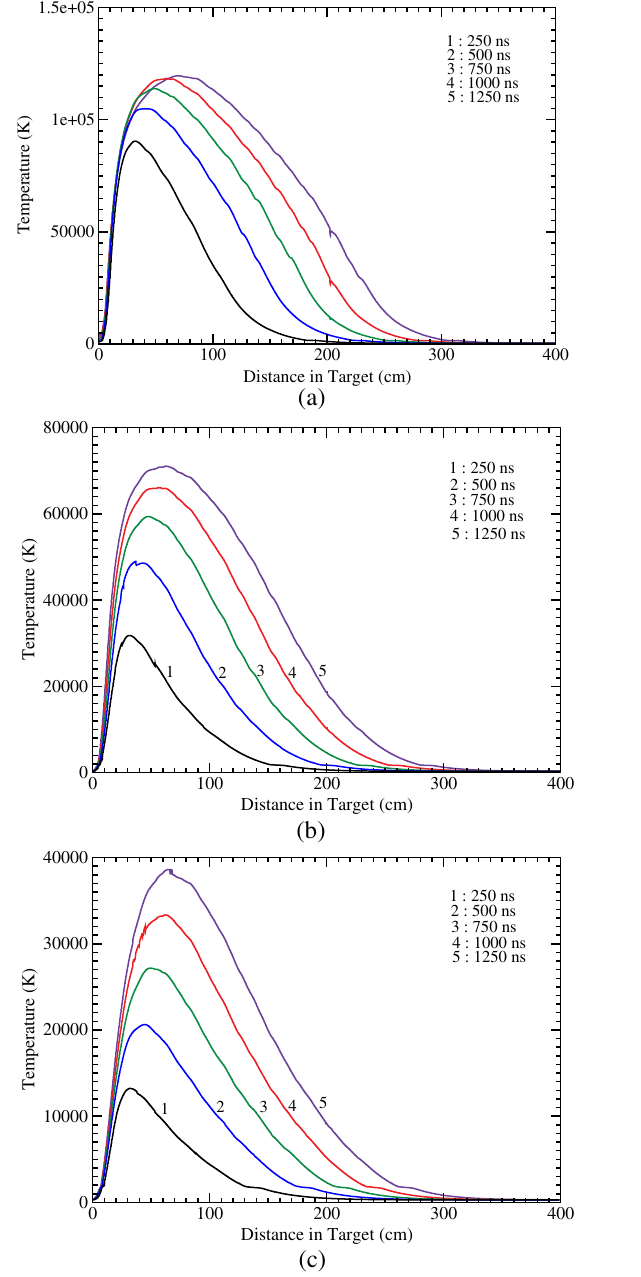
FIG. 6. Magnified view of the temperature profiles presented in Fig.